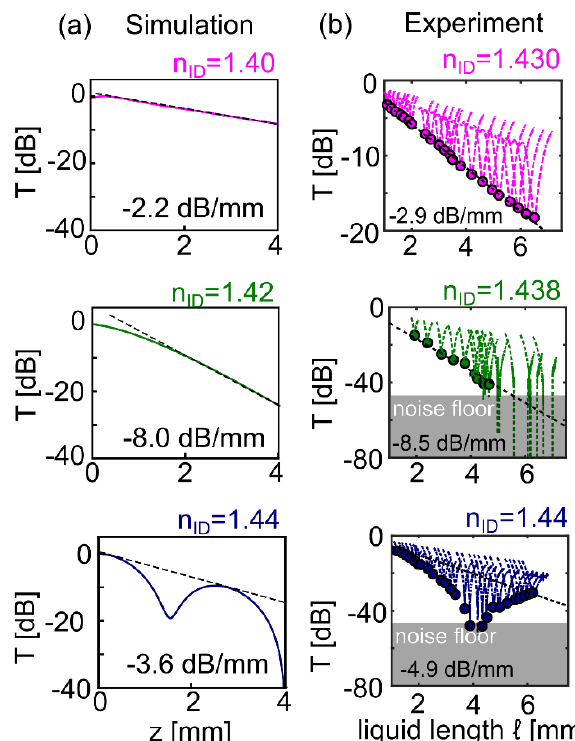
Fig. 2. (a) Calculated transmitted power at three example RIs. (b) Circles: measured on-resonance transmission as a function of ℓ for different analytes as labeled, showing the a crossing of the EP. Dashed lines show the full resonance spectrum centered in each transmission minimum (i.e., the horizontal axis of each spectrum is scaled by a factor ℓ/λ R [7]). Dashed lines: fitted loss as